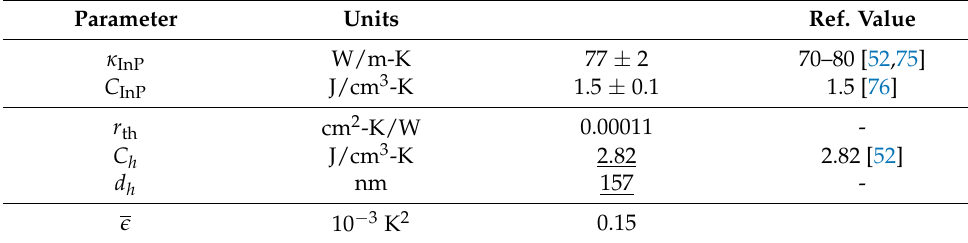
Table A5. Fitted parameter values for bulk InP.